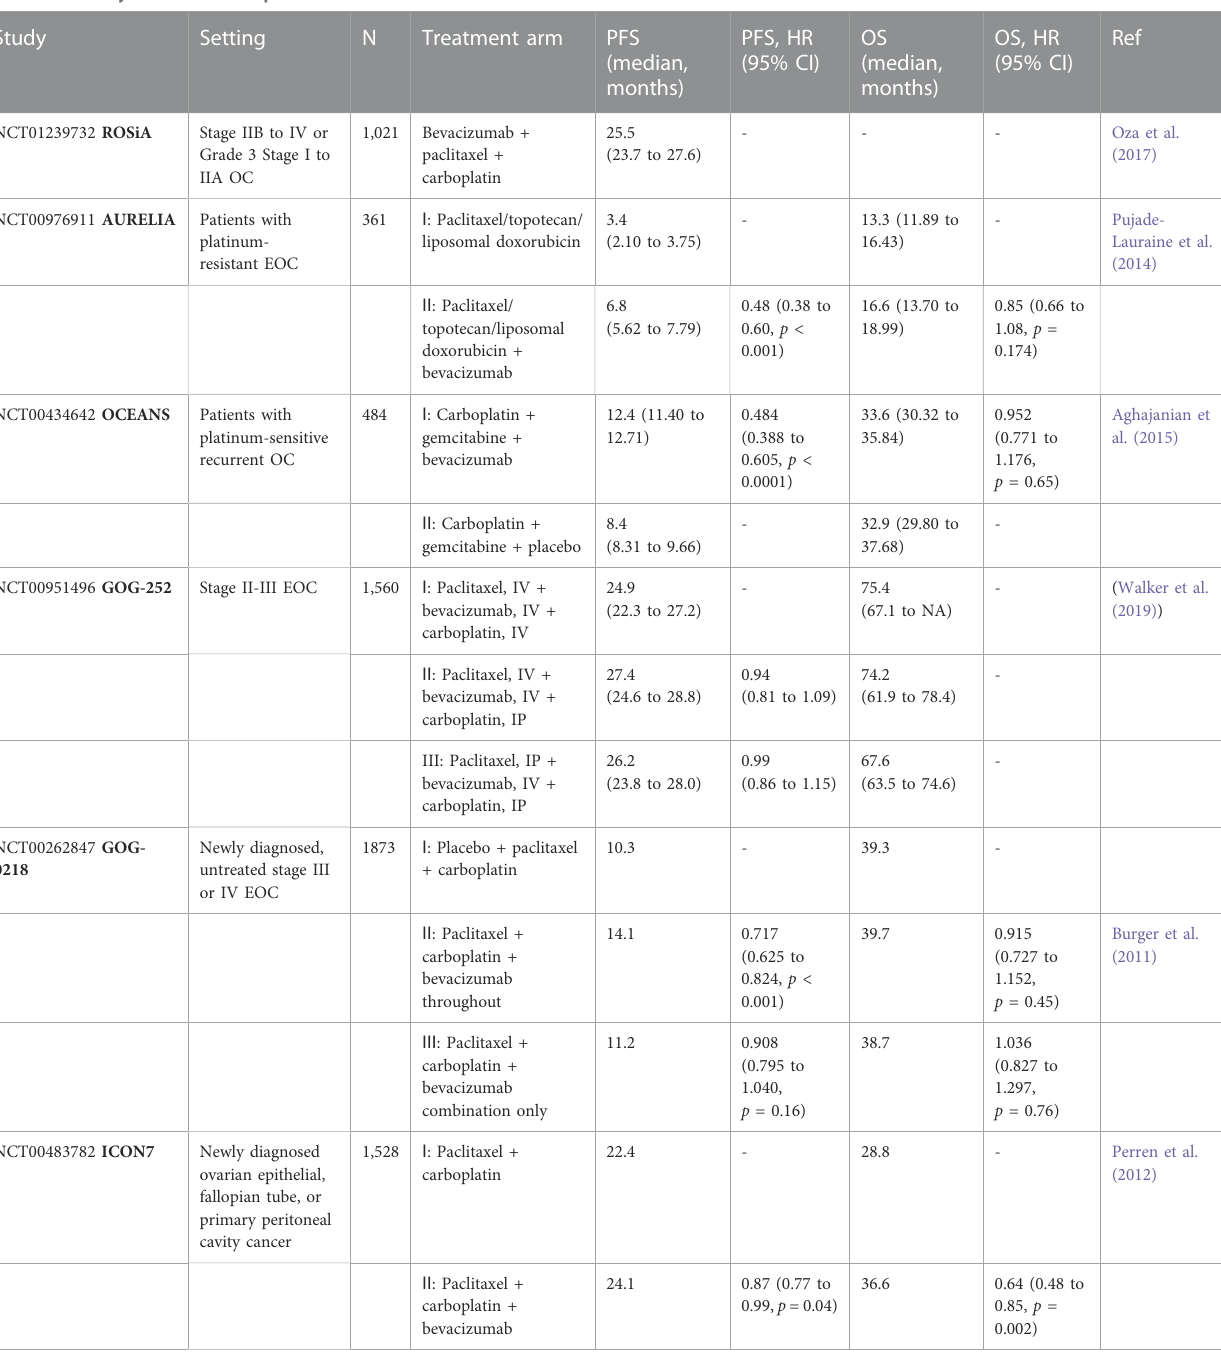
TABLE 1 Summary of bevacizumab phase III clinical trial.